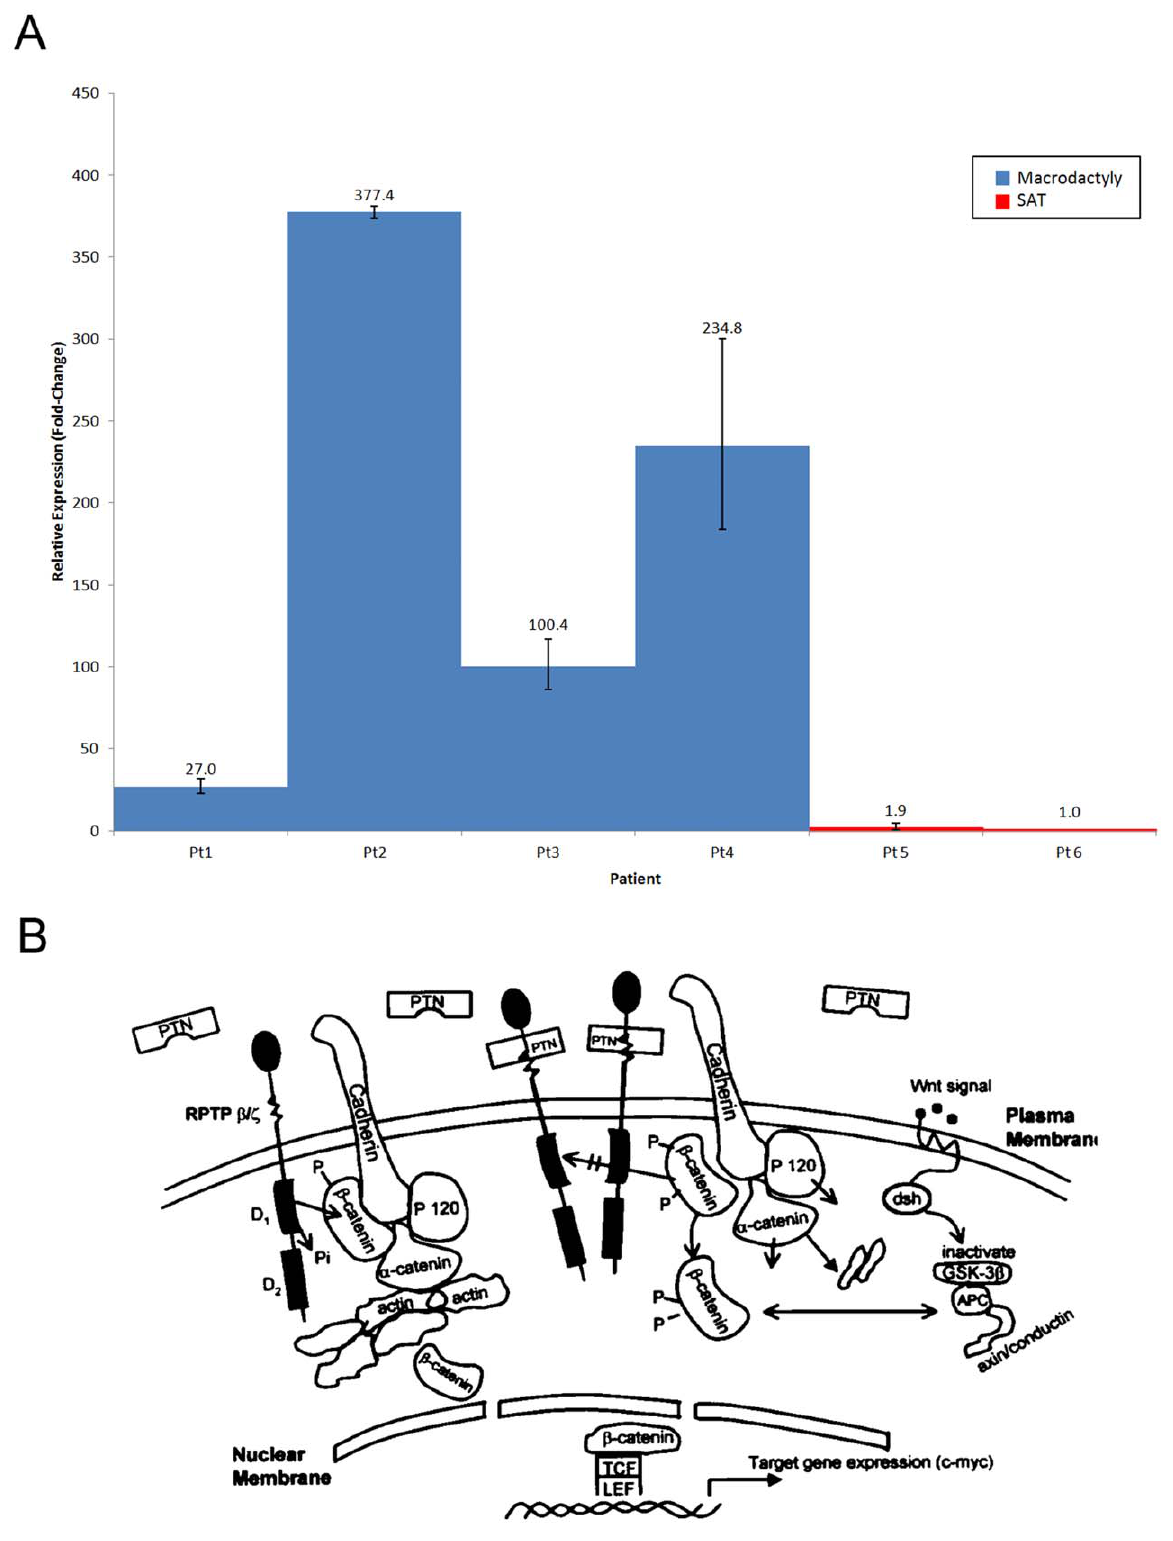
Figure 3. Confirmation of pleiotrophin (PTN) expression in macrodactyly and the known PTN signaling cascade. (A) Relative expression of PTN in macrodactyly vs. adult subcutaneous adipose tissue as determined by quantitative real time polymerase chain reaction. In macrodactyly, PTN averaged 127.6-fold overexpression (p=0.049). (B) The PTN signaling cascade and crosstalk with Wnt signalling (from Deuel et al.) 14 .